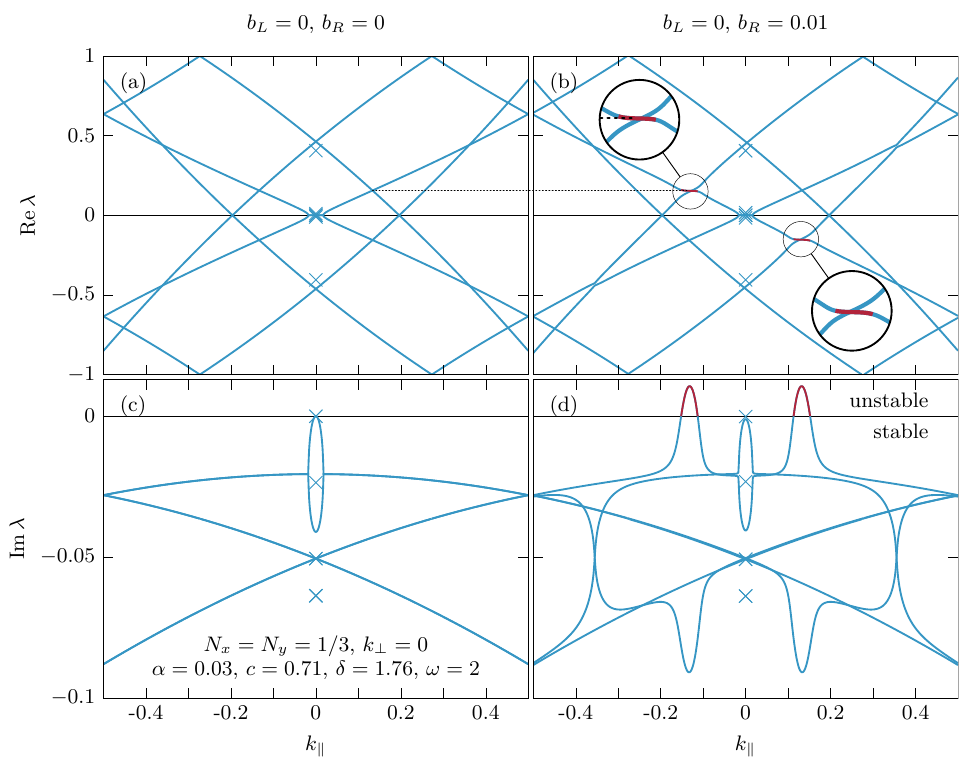
Figure 4: Eigenvalues λ of M F as a function of k (cid:107) , the component of k (cid:107) q , for a sys- k = N = N = 1 / 3, k = 0. All tem with parameters α = 0.03, c = 0.71, δ = 1.76, N ⊥ x y z graphs are in the first Brillouin zone − q / 2 < k (cid:107) < q / 2. The real parts of the eigenfre- quencies Re [ λ ] are plotted in the first Floquet zone, between − ω/ 2 < Re [ λ ] < ω/ 2 with ω = 2. The two graphs in the left column are the real and imaginary parts of λ for an undriven system. All imaginary parts are negative, indicating that the conical static state is stable, as expected. The two graphs in the right column show the band energies for a driven system where the driving magnetic field is left circular polar- = 0.01, b = 0, with driving frequency ω = 2 very close to the resonance ized: b L R frequency ω . The parts of the imaginary spectrum highlighted in red are unsta- res, + ble, and occur for k (cid:107) ∼ 0.13 q , which corresponds to a Re [ λ ] = ± 0.16. The crosses denote the spectrum at k = 0, which differs from the spectrum for k → 0 due to the long-ranged dipolar